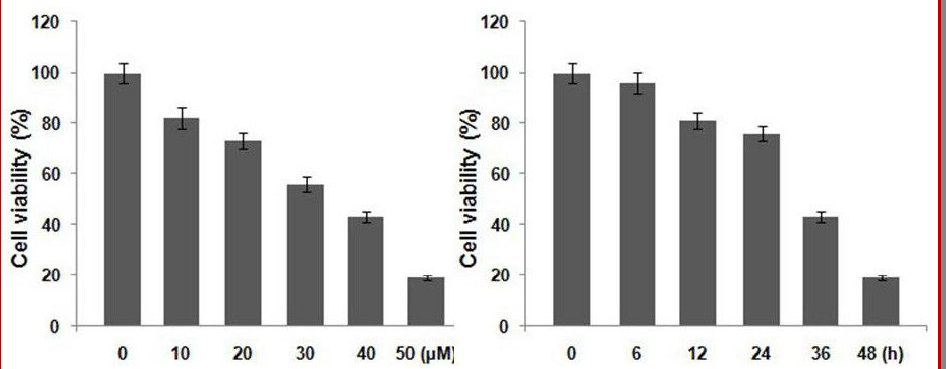
Figure 2: 2-Florobenzaldehyde retinoic acid conjugate inhibited proliferation of U373 glioma cells in a concentration- and time- dependent manner. The cells after treatment with conjugate were analyzed using BrdU